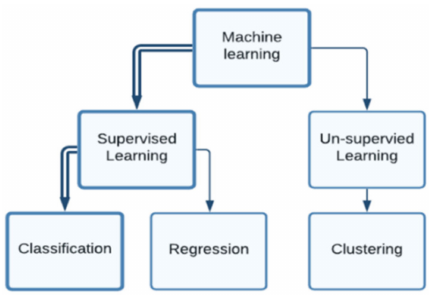
Figure 2. The presence of a dataset tends to predict continuous